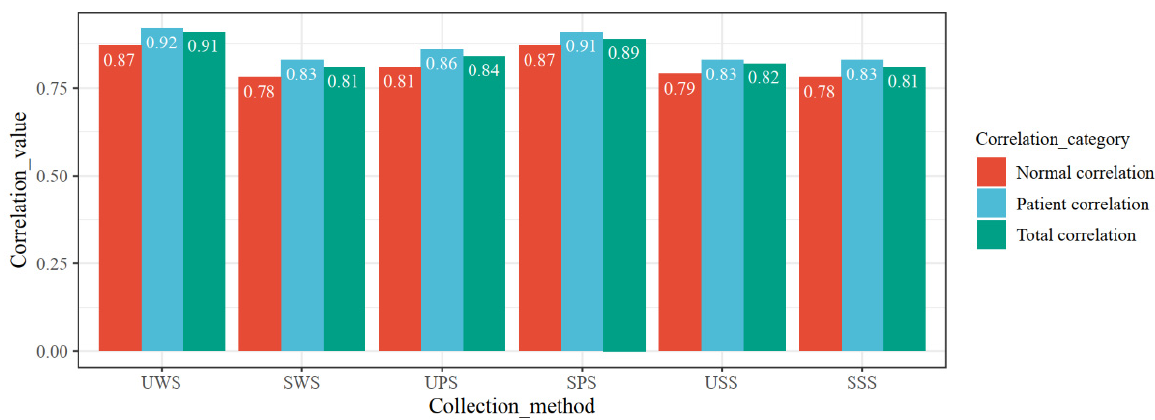
Figure 4. Correlation between six collection methods and blood cortisol.